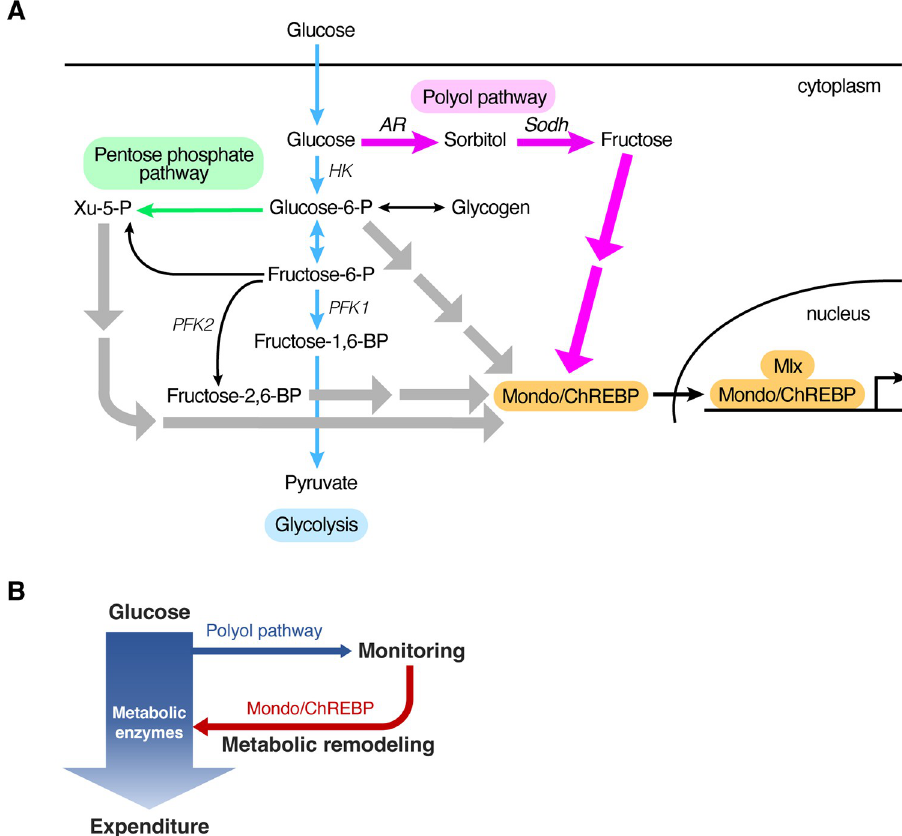
Fig 6. The role of the polyol pathway. ( A ) Metabolic pathways leading to Mondo/ChREBP activation. Glucose- 6-phosphate (Glucose-6-P), xylulose-5-phosphate (Xu-5-P), and fructose 2,6-bisphosphate (Fructose-2,6-BP) were identified previously as MondoA/ChREBP-activating metabolites in mammalian cell culture systems (gray arrows) [2]. These metabolites are generated in glycolysis (blue arrows) or PPP (green arrow). Our study revealed that the polyol pathway (magenta arrows) has a significant contribution to activating Mondo/ChREBP in flies and mice (magenta arrows). ( B ) Physiological roles of the polyol pathway. The polyol pathway monitors glucose levels and regulates Mondo/ChREBP accordingly. This system allows animals to adjust metabolic activities to glucose availability and perform proper physiological functions. AR, aldose reductase; ChREBP, carbohydrate response element-binding protein; HK, hexokinase; Mlx, Max-like protein X; PFK1, phosphofructokinase 1; PFK2, phosphofructokinase 2; PPP, pentose phosphate pathway; Sodh, sorbitol